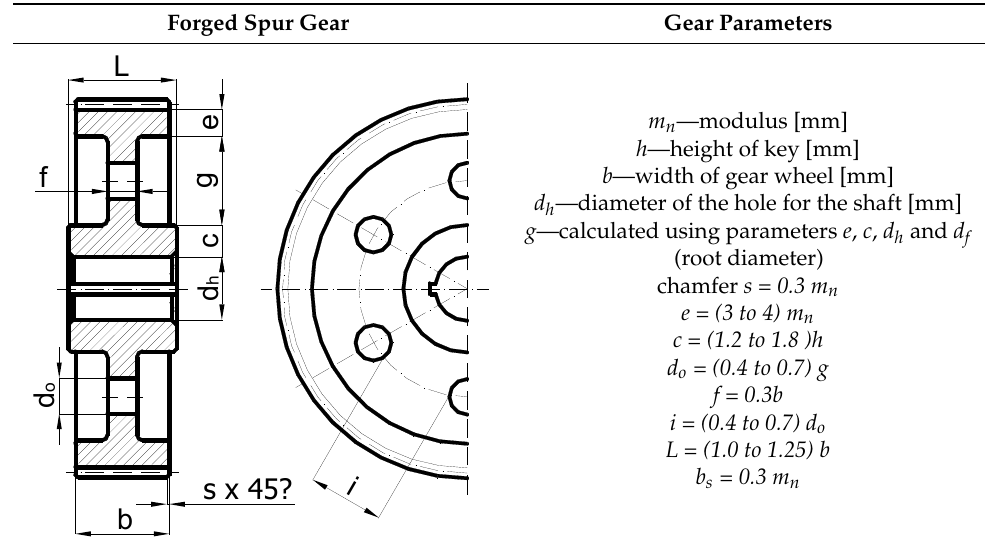
Figure 1. Body shapes of forged spur gears: ( a ) shape without relief holes; ( b ) the most commonly used shape of forged spur gears; ( c ) shape with openings for weight reduction. Table 1. Forged spur gear—basic geometric parameters.